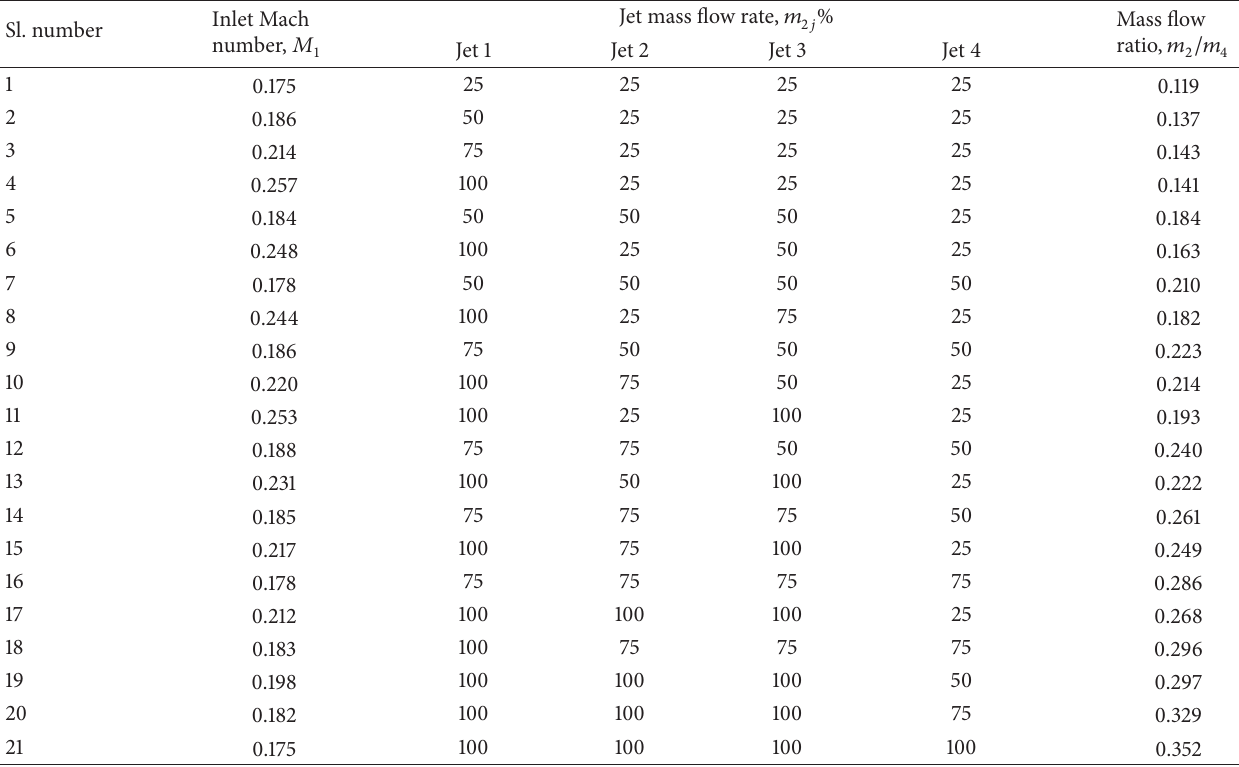
Table 1: Flow cases chosen for